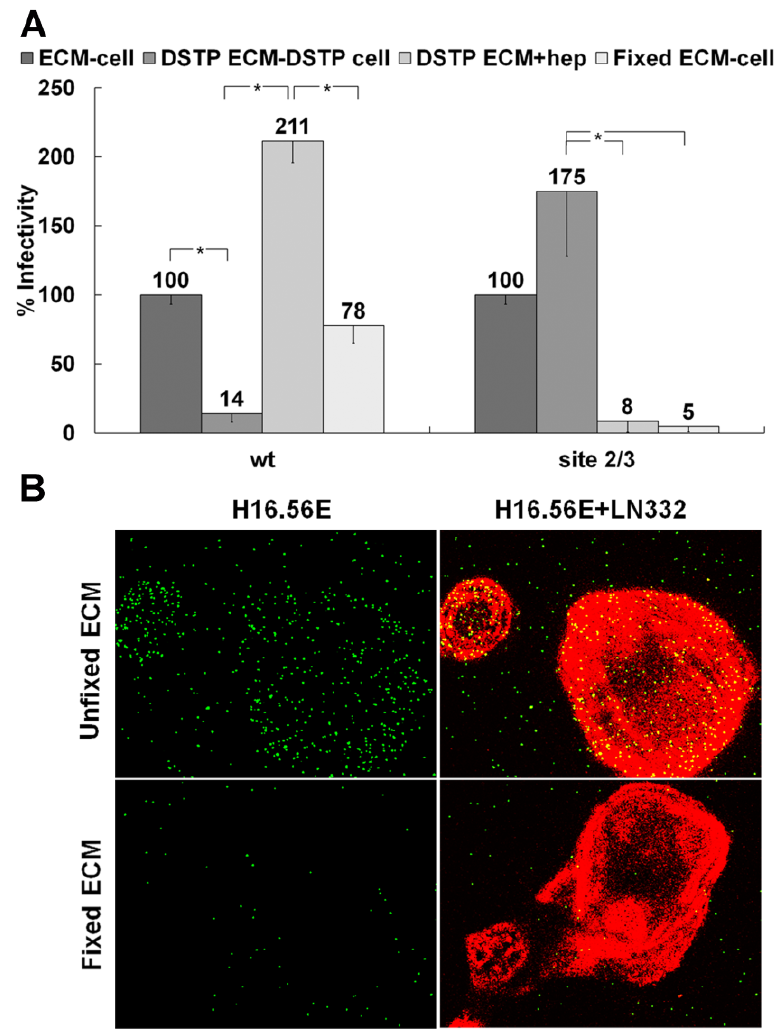
Figure 1. ECM cofactor facilitates infectious entry. ( A ) HPV16 wt or mutant site 2/3 (K54A/K356A-N57A/K59A-K442A/K443A) virus was allowed to bind to the ECM secreted by HaCaT cells. The ECM was untreated, treated with DSTP27 or fixed with 4% PFA. When indicated, 293TT cells were also treated with DSTP27. For the DSTP ECM+hep, detector 293TT cells were incubated with 10 μg/mL heparin. Infectious transfer to 293TT cells was scored using flow cytometry 72 hpi; ( B ) HaCaT cells were grown on coverslips for 48 h and subsequently removed with 0.5 M EDTA in PBS. The ECM depositions were either untreated or fixed with 4% PFA. Wt HPV16 virus was incubated with 10 µg/mL heparin and then added to coverslips. LN332 reactivity is shown in red; virus was detected with H16.56E (added prior to fixation of the virus) and is shown in green. When the statistical significance of a data set as determined by a Student’s t -test differed from control by p ≤ 0.001, it is indicated in the graph ( *